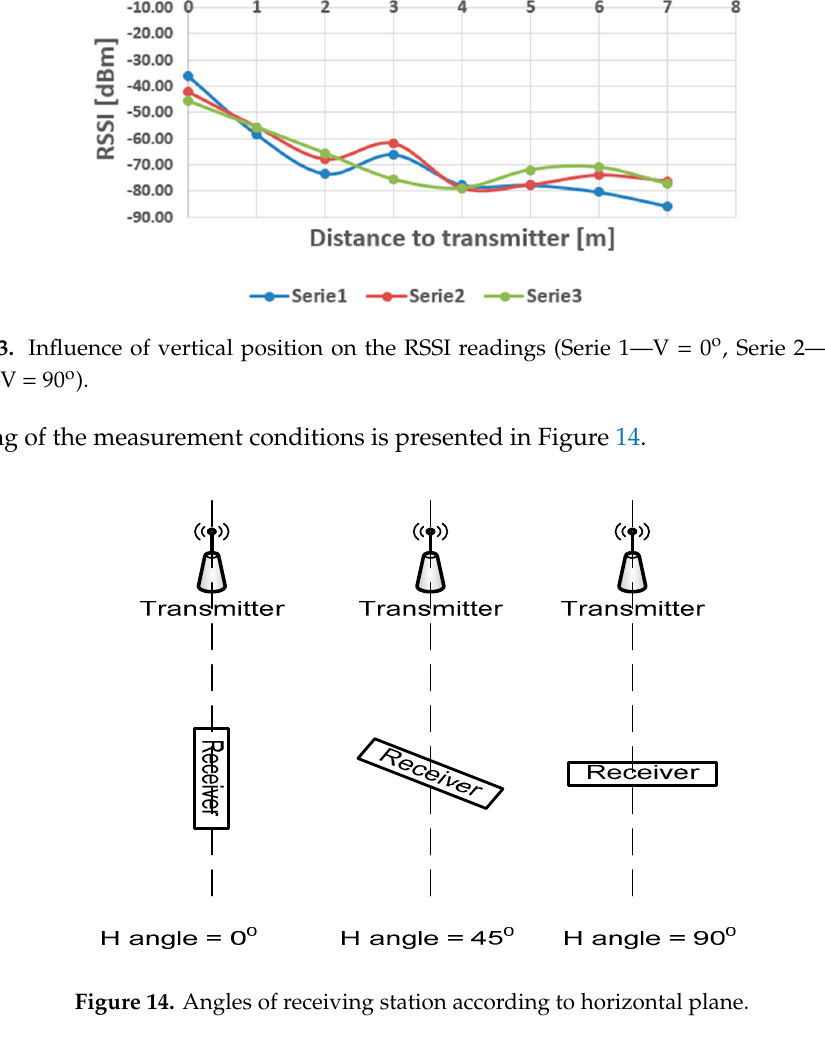
Figure 14. Angles of receiving station according to horizontal plane.